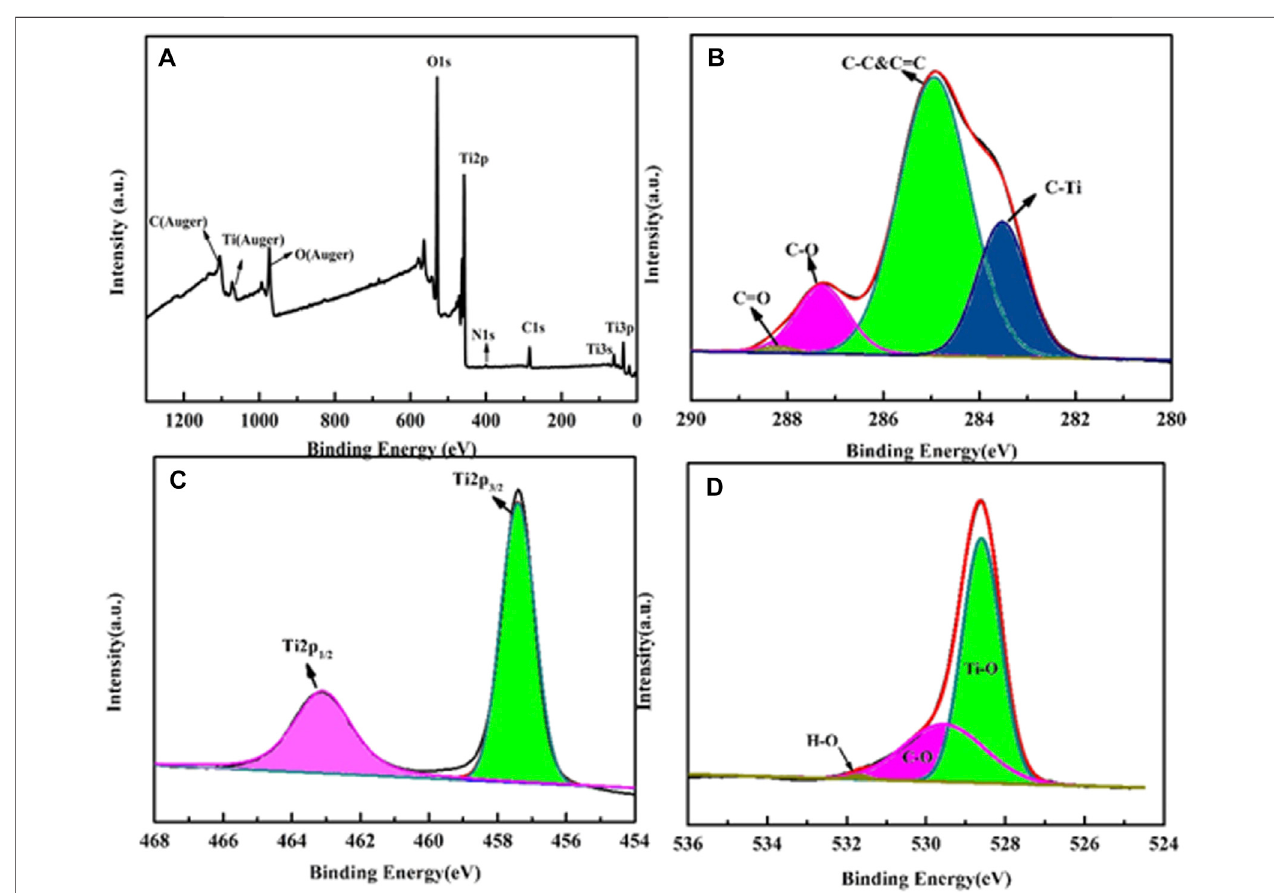
FIGURE 4 | XPS spectra of 0.2CD-TNs: (A) survey XPS spectrum, (B) C1s, (C) Ti2p, and (D) O1s